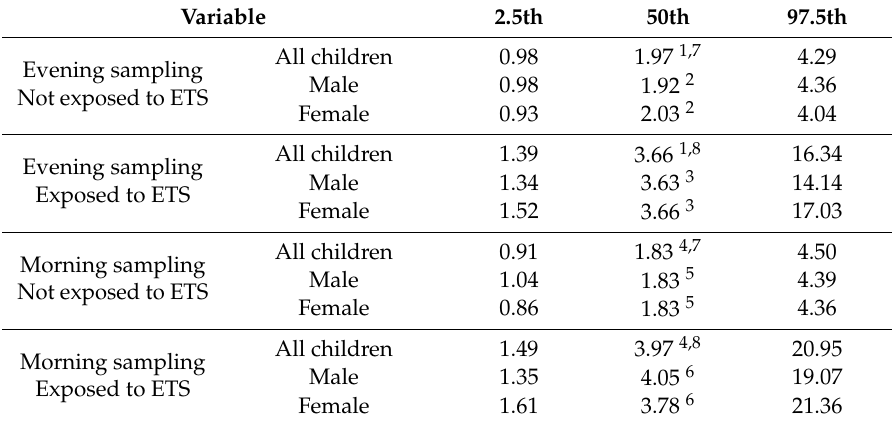
Table 2. Reference values of urinary cotinine levels (expressed as µ g L − 1 ) for children not exposed and exposed to Environmental Tobacco Smoke (ETS) calculated for all participants and according to